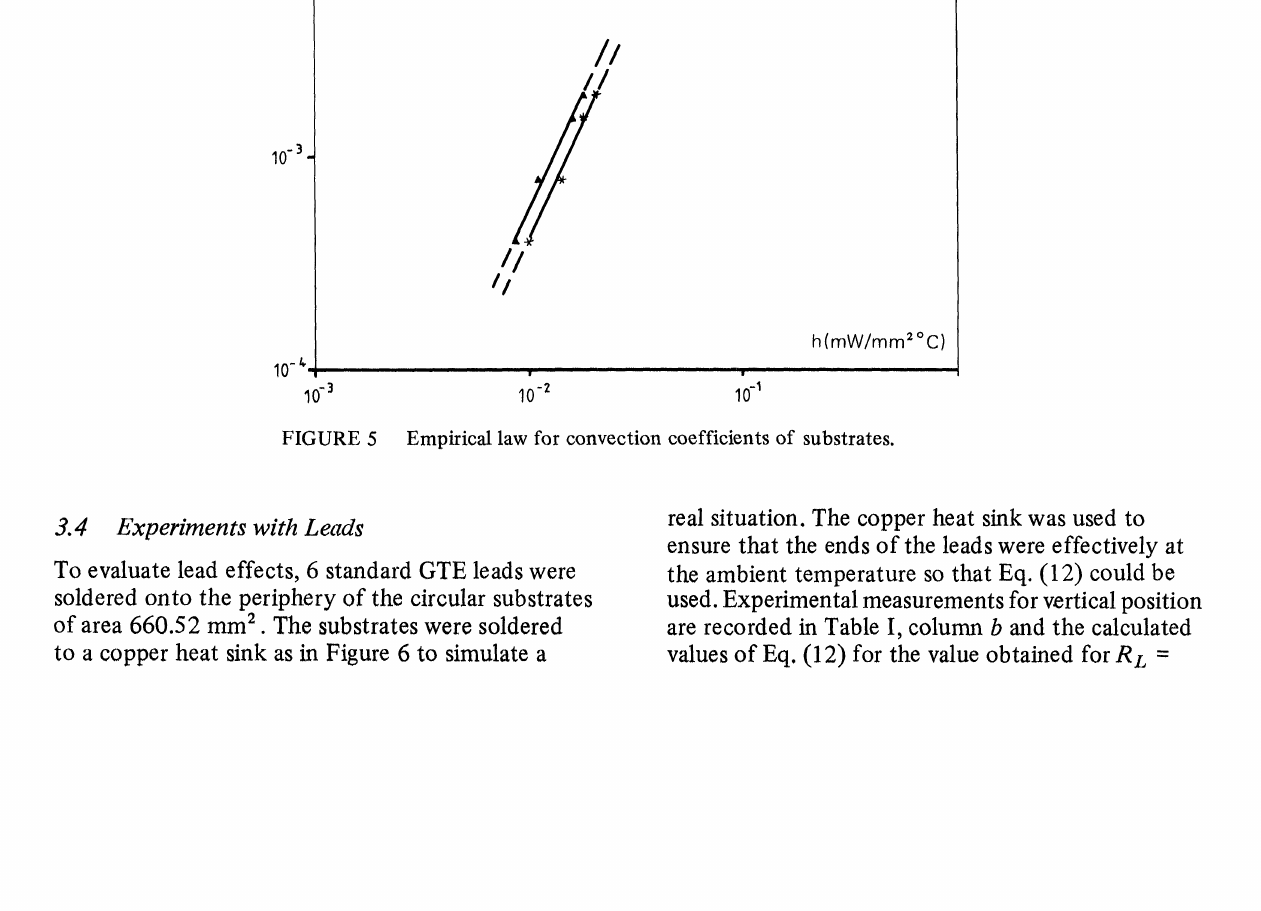
FIGURE ,4 Experiments with rectangular substrates.